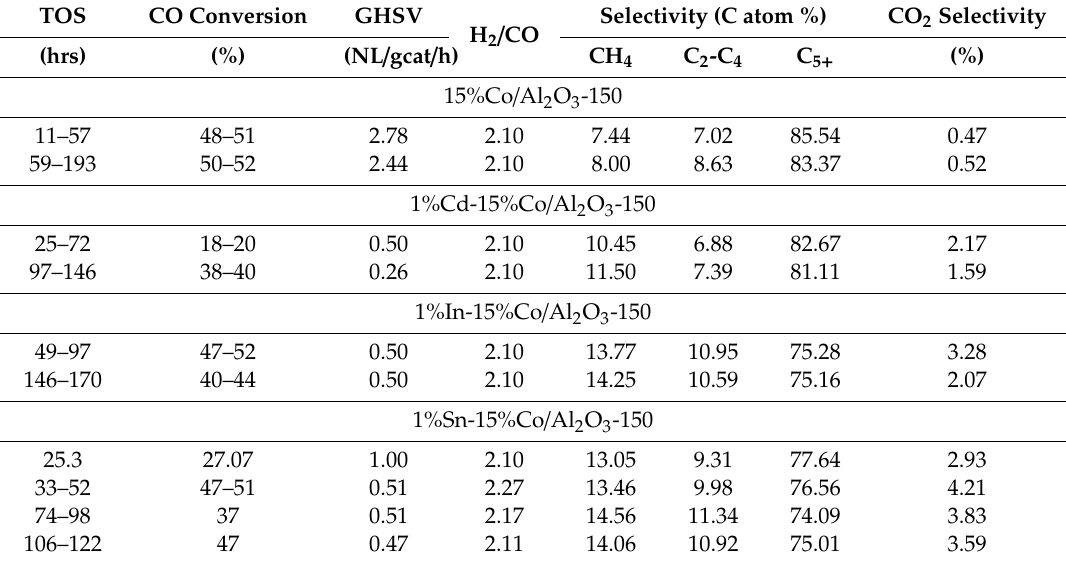
Table 2. Activity and selectivity of unpromoted and Cd, In, Sn and Pt promoted 15%Co / Al 2 O 3 catalysts (a)